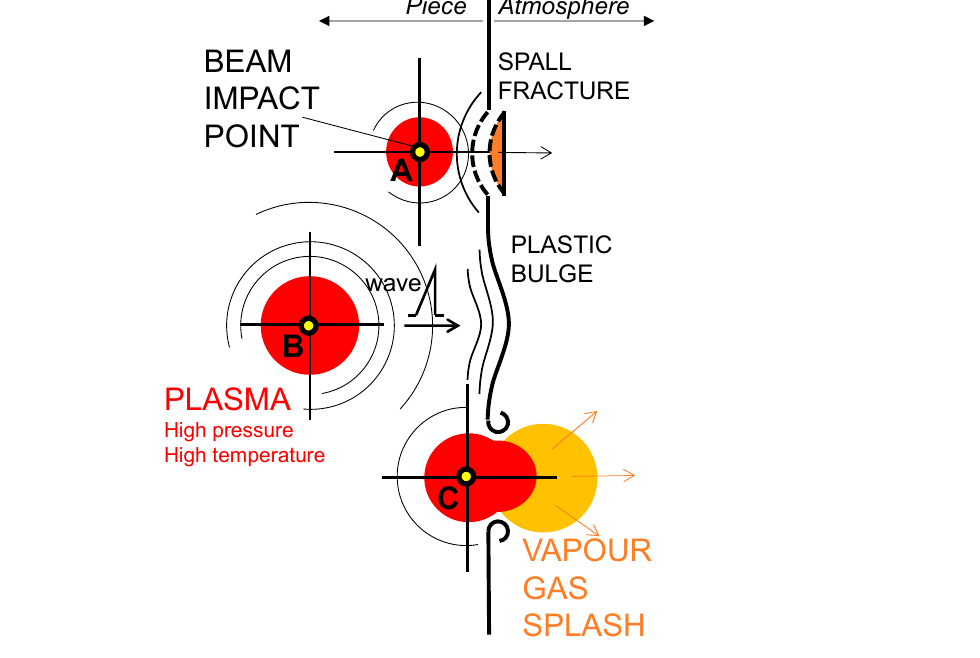
Figure 2. Scheme of the possible scenarios in case of particle beam impact against a solid target: the cases A and B represent an impact occurring far from a free surface; the case C indicates an impact occurring close to a free surface.